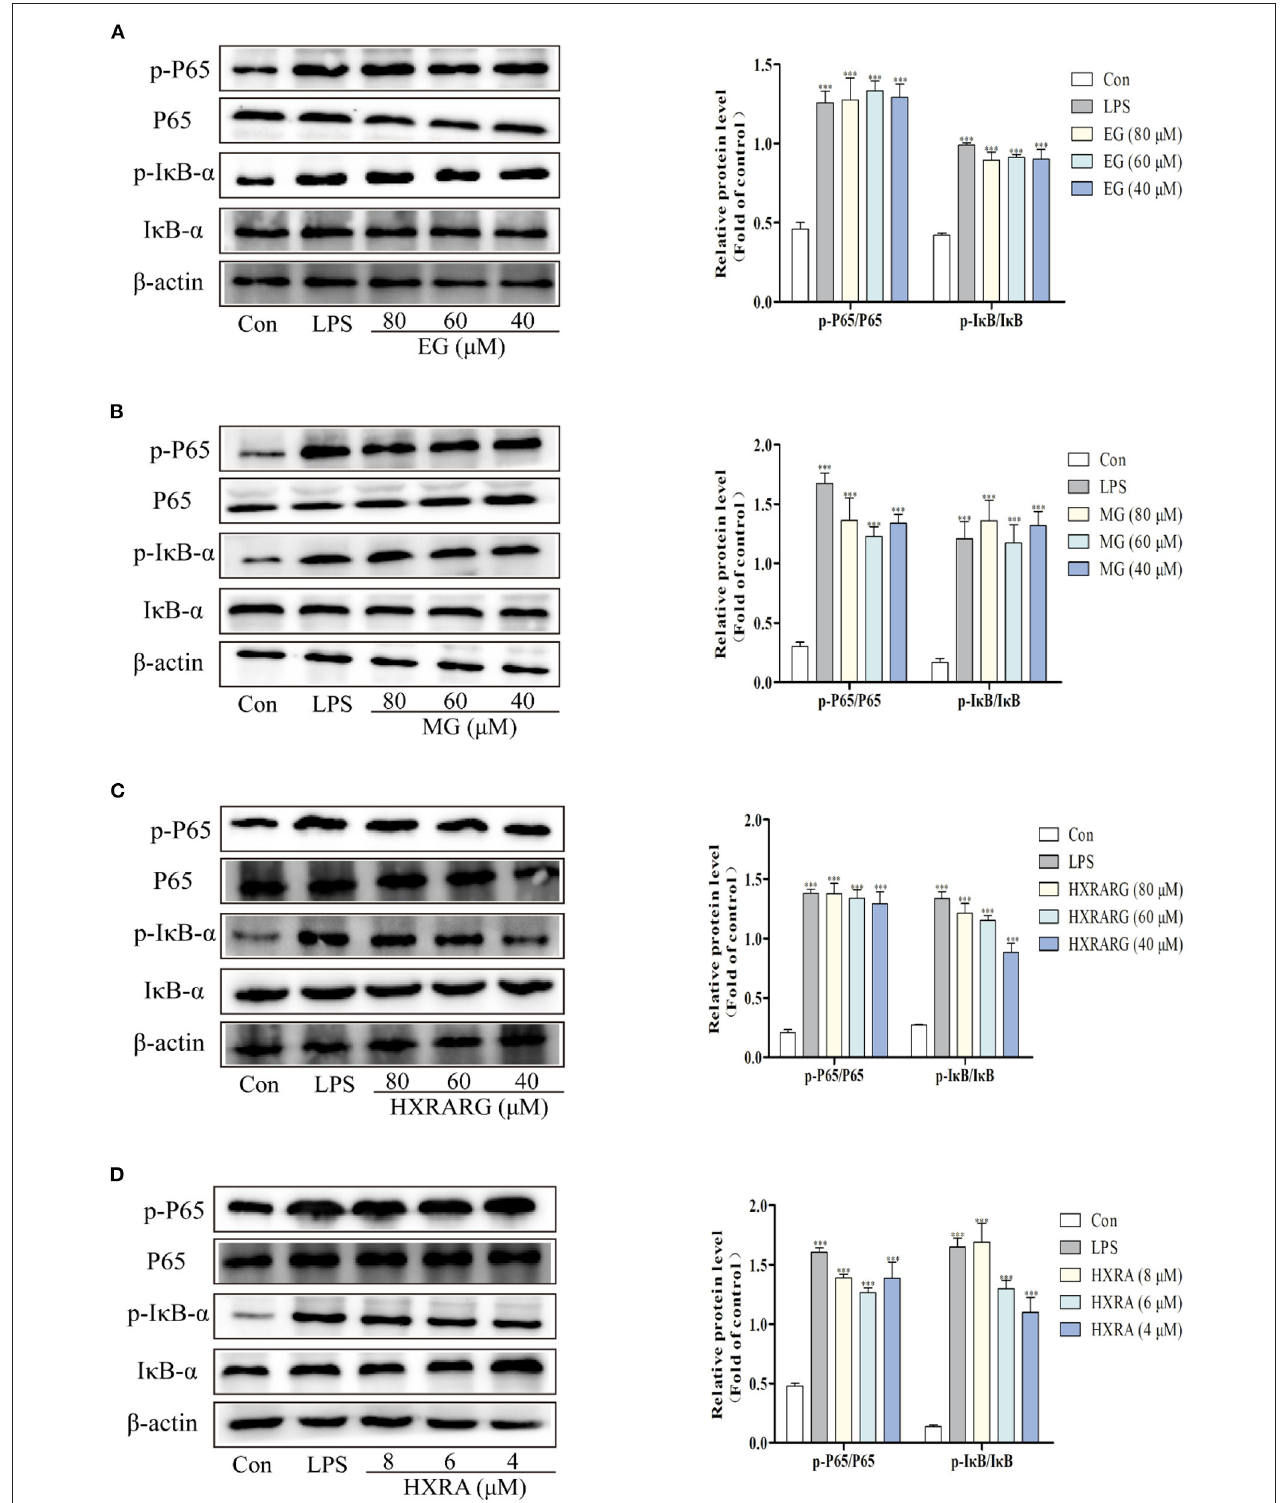
FIGURE 8 | Effects of different concentrations of EG (A) , MG (B) , HXRARG (C) , and HXRA (D) on the expression of related proteins in NF- κ B signaling pathway in RAW264.7 cells. The left side was the protein band diagram, and the right side was the protein quantification diagram. Data are expressed as the means ± SD. Compared with the control, *** P <